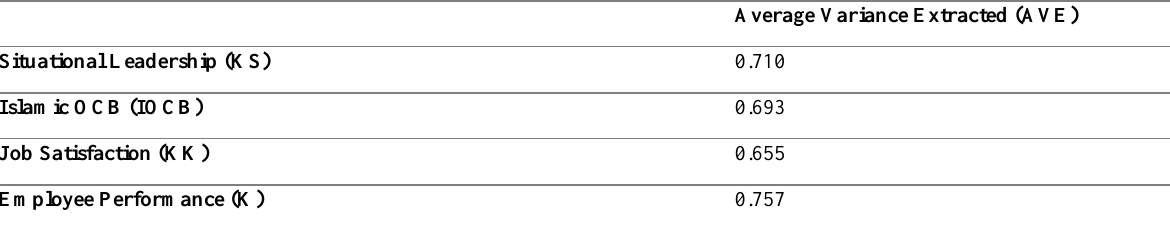
Table 1: Average Variance Extracted (AVE)